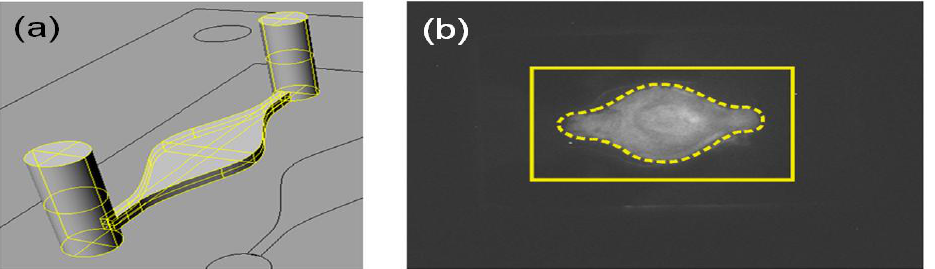
Figure 5. ( a ) Drawing of the flow cell used for protein incubation (volume 18.6 μL, Area = 0.744 cm 2 , height = 250 μm). ( b ) Chemiluminescence picture showing protein G binding on PPAA coated corning glass (yellow contour). The area exposed to the flow solution containing HRP-conjugated protein G (15 μg) is indicated by the yellow dashed